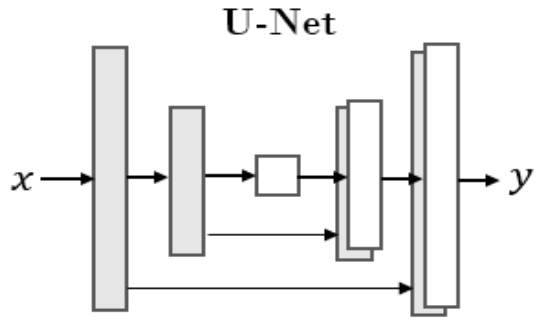
Figure 10. The structure of U-Net network.